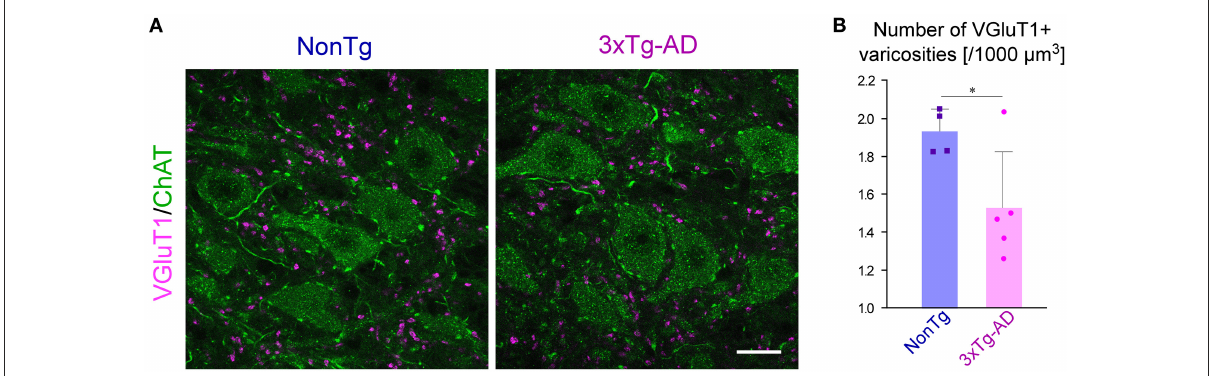
FIGURE3 The density of VGluT1-immunopositive varicosities in the Vmo. (A) Representative confocal image of the center of dorsolateral Vmo. Motor neurons in the Vmo were labeled with ChAT immunoreactivity (green). In the Vmo, VGluT1-immunopositive varicosities (magenta) derived from the Vmes are located only in the dorsolateral part of the Vmo innervating the jaw-closing muscles. The density of VGluT1-immunopositive varicosities appeared to be decreased in 3 × Tg-AD mice than in NonTg mice. (B) The 3-month-old 3 × Tg-AD mice ( n = 5) showed a significant reduction in the density of VGluT1-immunopositive varicosities compared to NonTg mice ( n = 4) ( * p = 0.0402, two-tailed unpaired t -test). Scale bar: 10 µ m (A) .